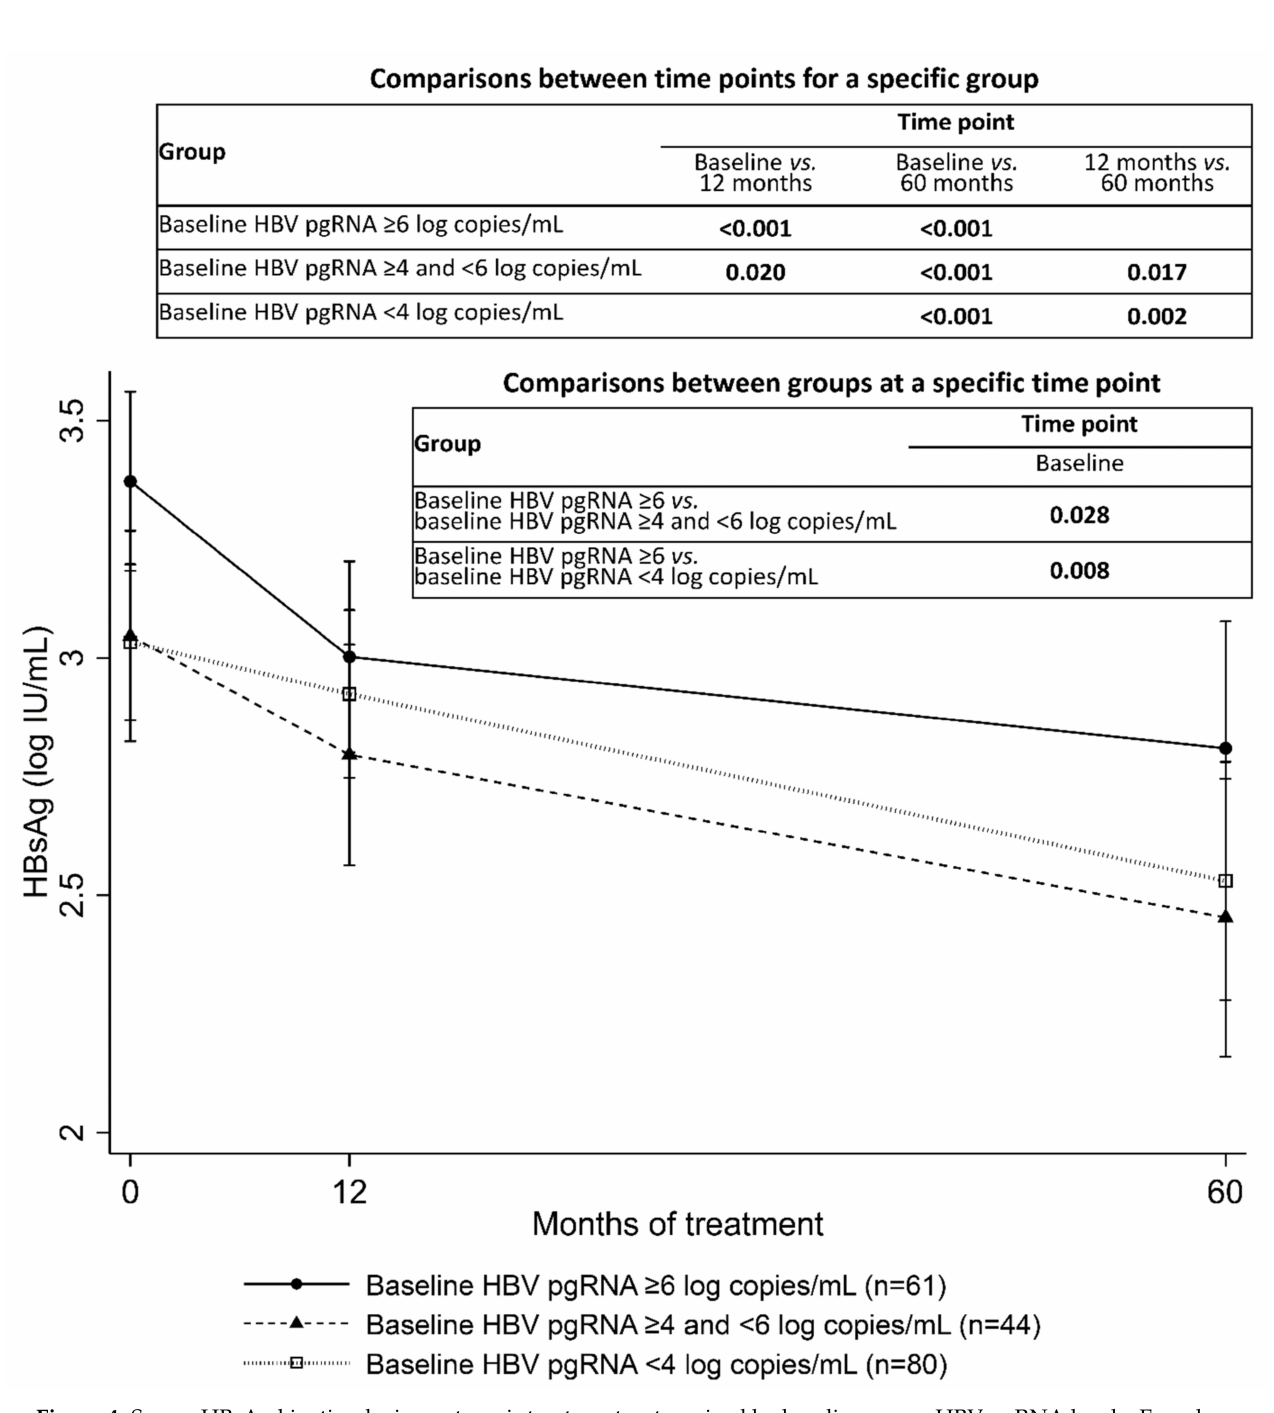
Figure 4. Serum HBsAg kinetics during entecavir treatment, categorized by baseline serum HBV pgRNA levels. Error bars represent 95% confidence intervals. Significant p values are